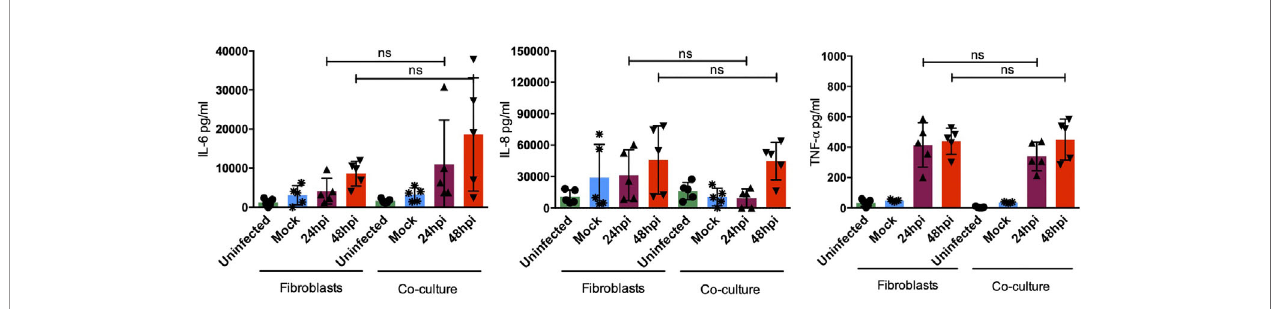
FIGURE 7 | The pro-in fl ammatory environment is not affected by dendritic cells. Pro-in fl ammatory cytokine evaluation in HDF and HDF:moDC cocultures after the speci fi ed infection times. Error bars indicate the standard deviations for the three independent experiments of each donor; n = 5. ns, no signi fi cant.